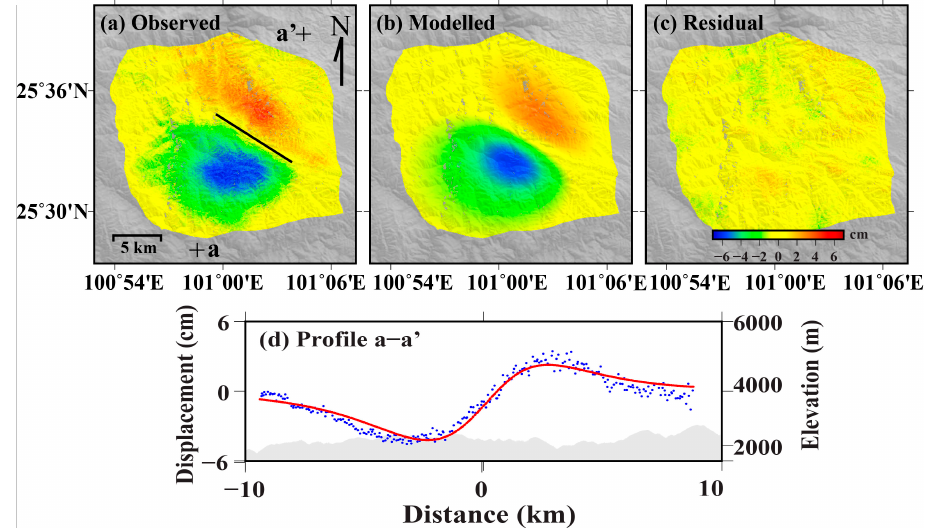
* The X-coordinate/Y-coordinate location is the mid-point of top edge of the modeled fault (the magnitude of the dip angle is negative). The longitude and latitude of reference point of the X- and Y-positions are 101.083° and 25.535°, respectively.